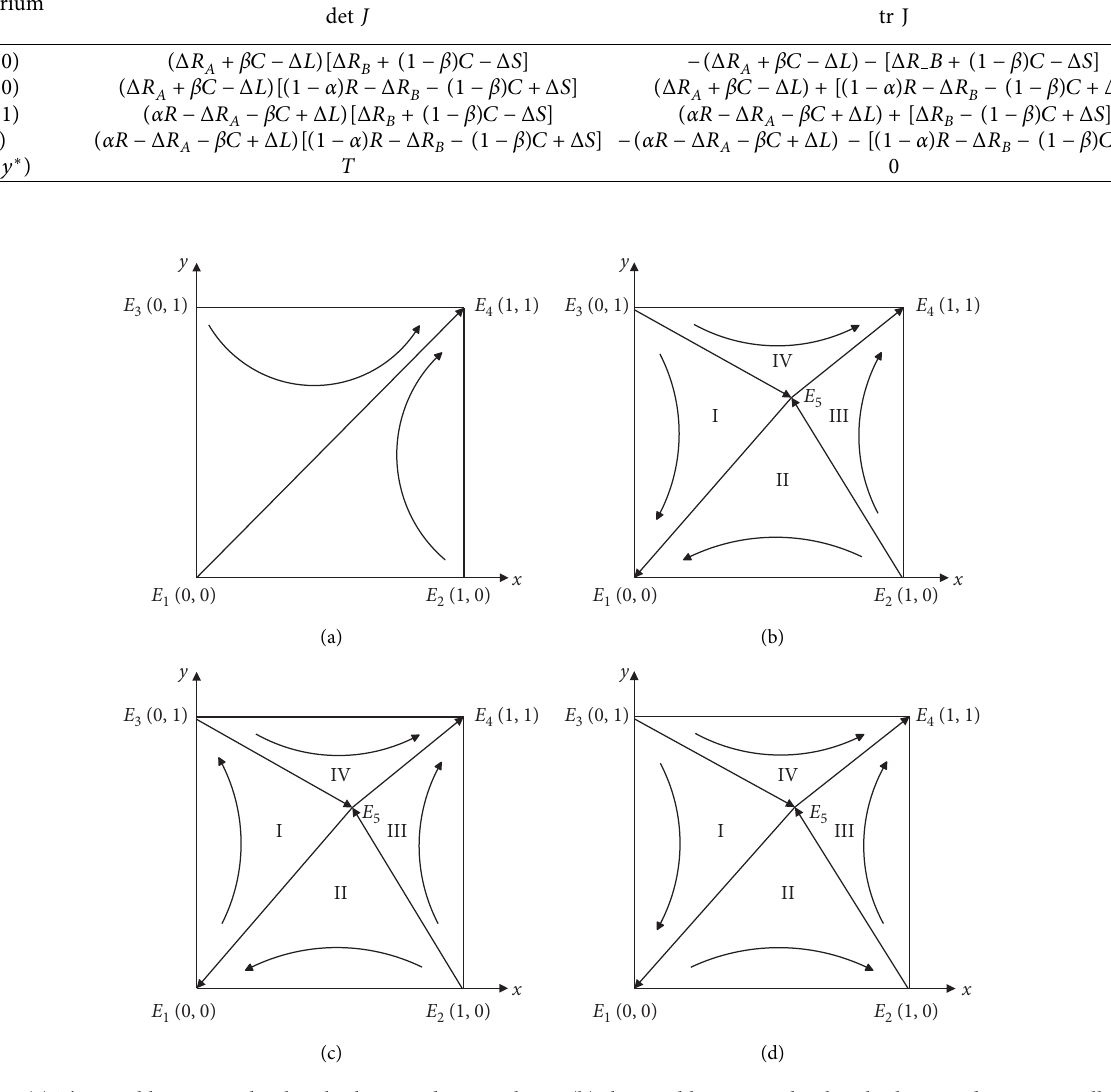
Table 2: The determinant and trace of the Jacobi matrix at five equilibrium points. Equilibrium point